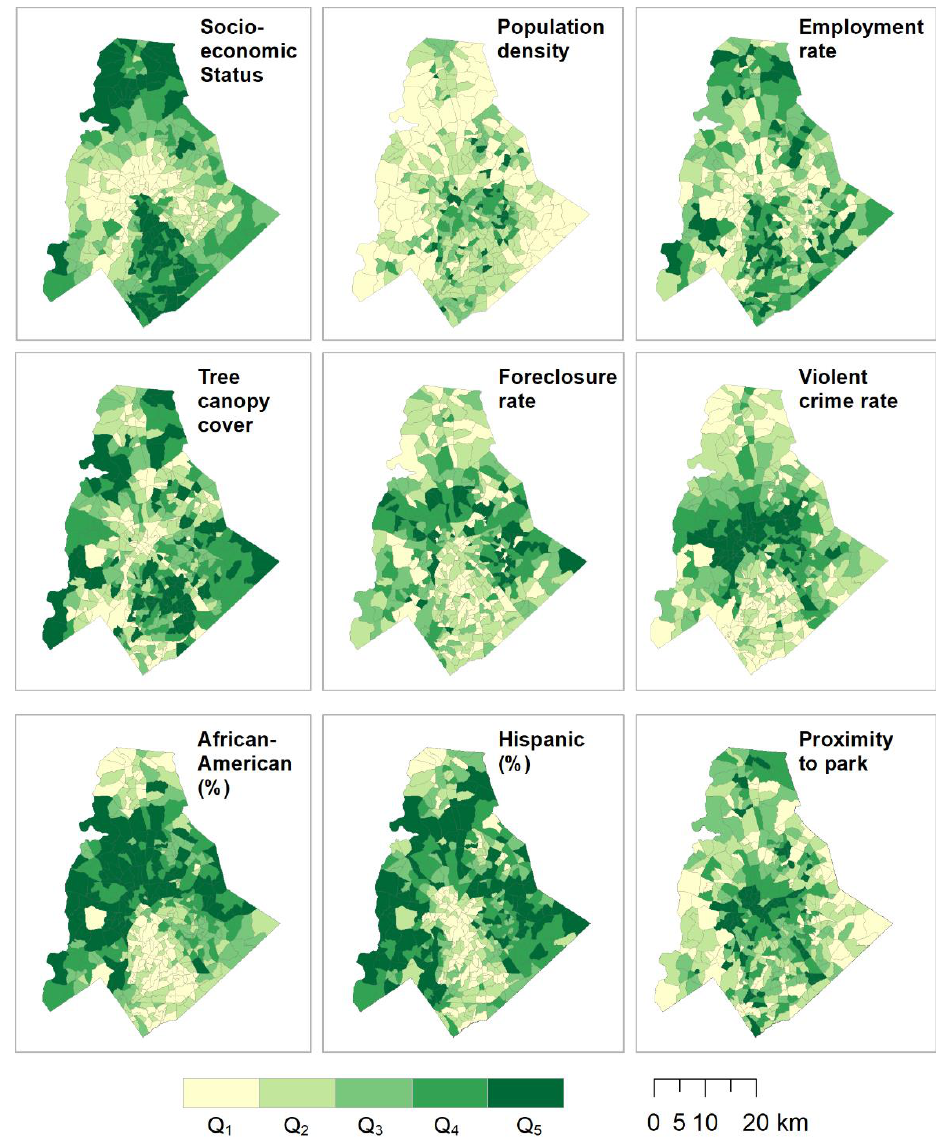
Figure 2. These nine variables, broken into quintiles, were used in the optimization process to identify NPAs suitable for